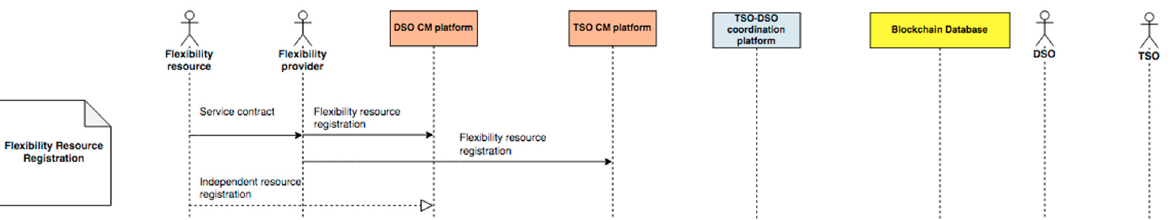
Figure 10. Flexibility asset registration.